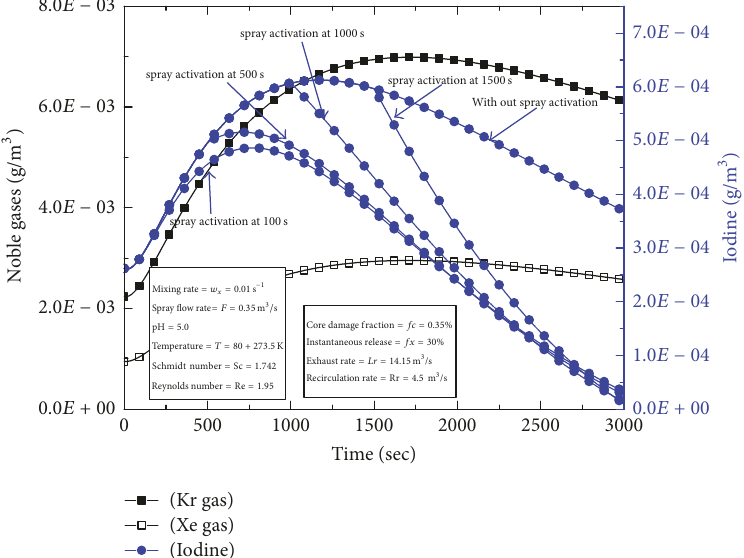
Figure 9: Noble gases and iodine inventory during in-vessel release phase with mixing rate 𝑤 푥 = 0.01s −1